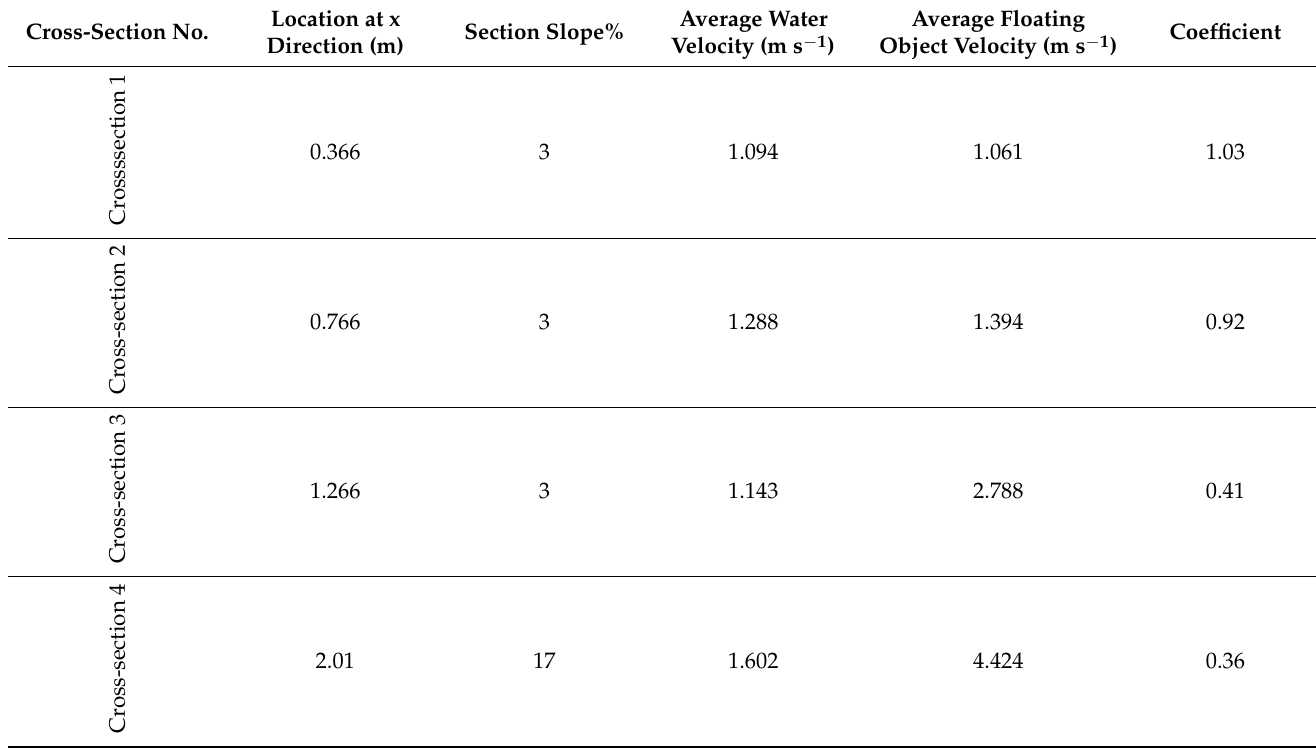
Table 7. Velocity correction coefficients for the current spillway model experiment.